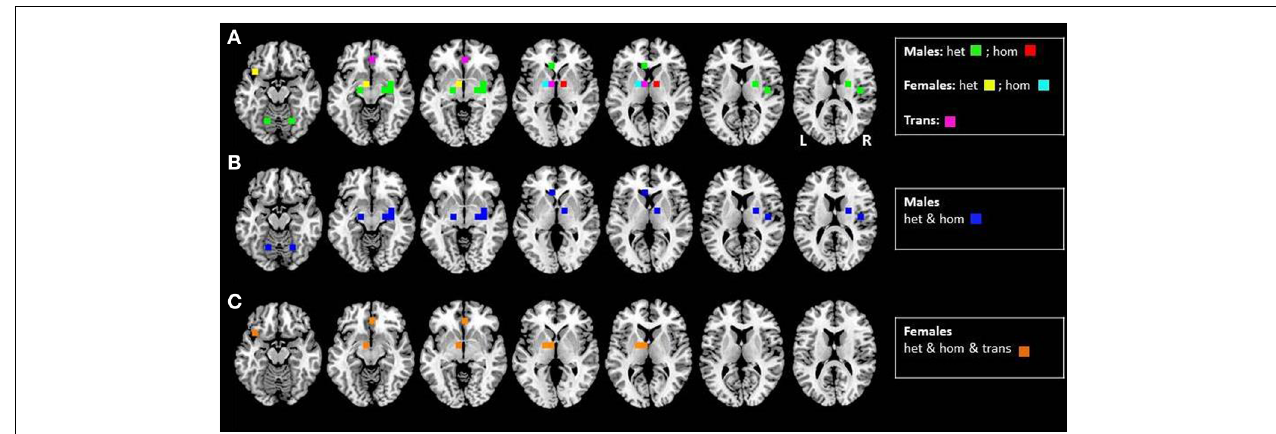
FIGURE 1 | Axial mean anatomical images overlaid with neural activation induced by AND, resulting from different functional imaging studies (see Table 2). In order to enhance comparability, we included all positron emission tomography (PET) studies using the same tracer, with the special pheromone-like compound that induced neuronal activation (see Table 2 ). Since results from certain subject groups were re-utilized as controls throughout these studies, these activations are illustrated once.